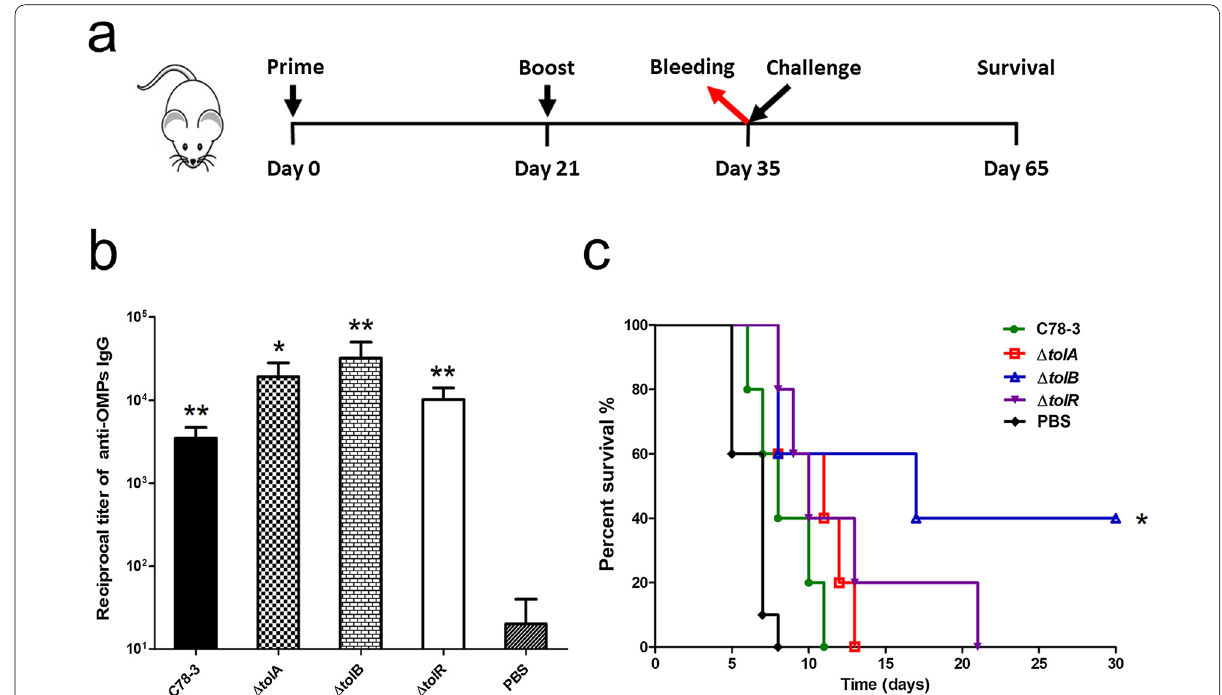
Fig. 6 Evaluation of immune responses and protection against S. Choleraesuis. a Scheme of immunization regimen. b Antibody responses induced by OMVs derived from C78-3, Δ tolA , Δ tolB , and Δ tolR strains. IgG titers against OMPs from C78-3 and three mutants groups were remarkably higher in contrast to the PBS group. c Survival of the mice subjected to immunization with OMVs obtained from C78-3, Δ tolA , Δ tolB , and Δ tolR strains. Intraperitoneal immunizations of PBS served as the negative controls. Two weeks posterior to the reinforce immunizations, all animals were challenged with the wild-type S. Choleraesuis. The infected mice were supervised every day for 30 days. * P < 0.05; ** P < 0.01; *** P <